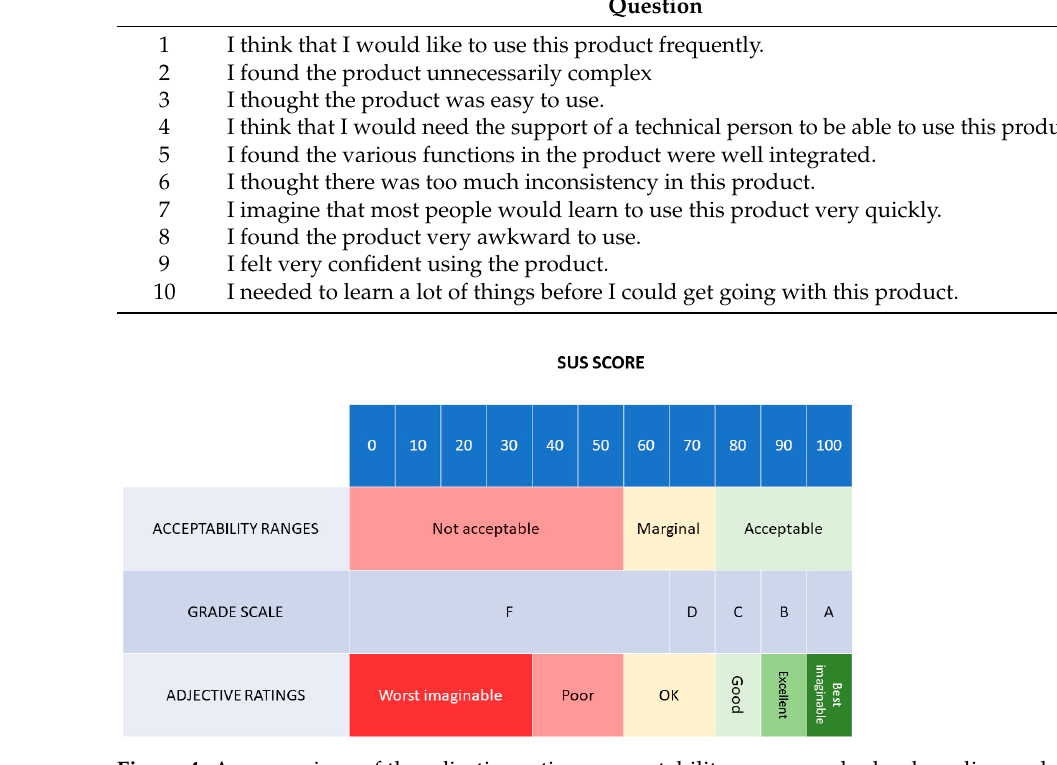
Figure 4. A comparison of the adjective ratings, acceptability scores, and school grading scales, in relation to the average SUS score [34].